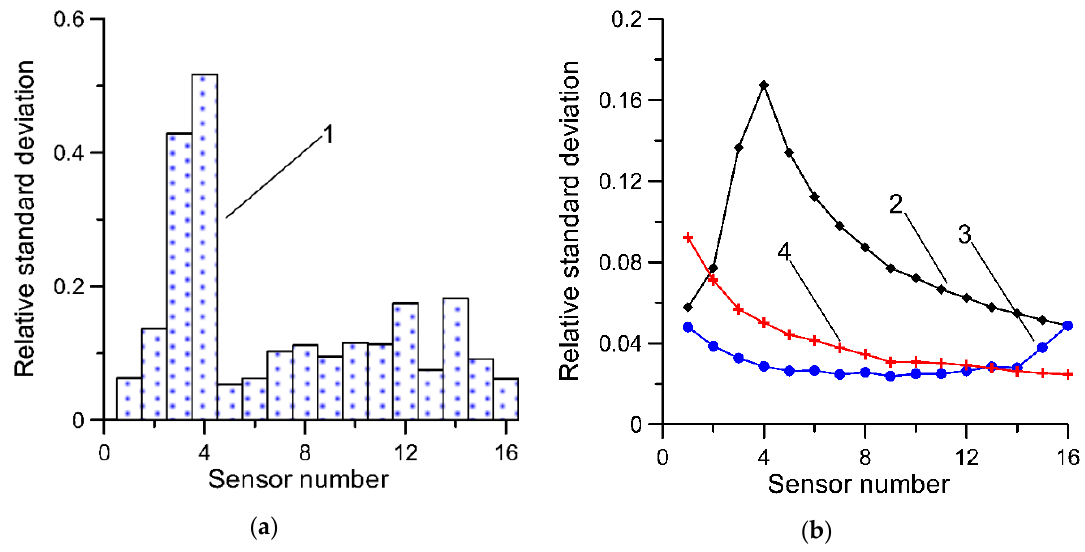
Figure 1. Relative (referring to the average value) standard deviation of estimates calculated on the basis of Equation (1) for various methods of averaging. ( a ) 1—standard deviation arbitrarily assumed for successive load sensors; ( b ) 2—averaging performed based on the order in which the sensors are installed in the pavement, 3—averaging in an order based on the increasing uncertainty of measurement for successive sensors, 4—measurement uncertainty of all sensors is uniform ( σ = 0.1). Characteristics determined for synthetic data.